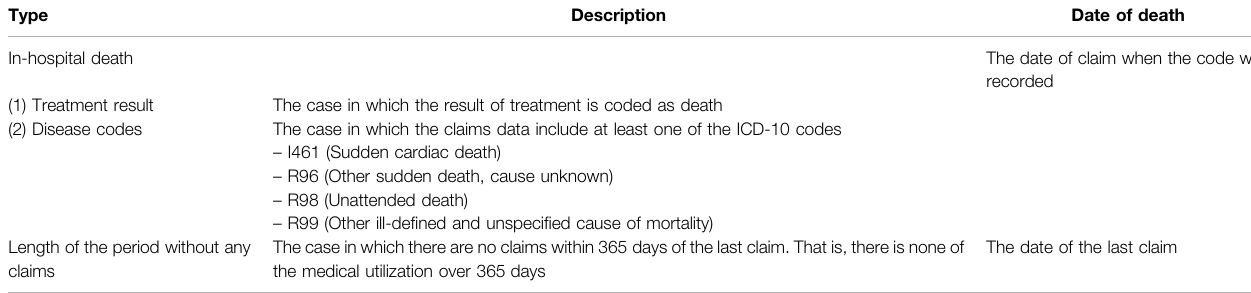
TABLE 1 | The operational de fi nition of death in claims